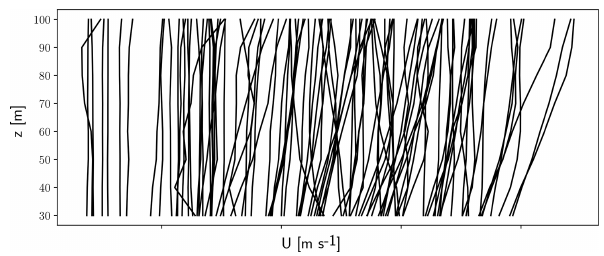
Figure 2. The 10min averaged vertical wind profiles at FINO2, where the wind speed at the lowest measuring point is shifted by 0.3ms − 1 per profile. Each profile is taken 20h after the